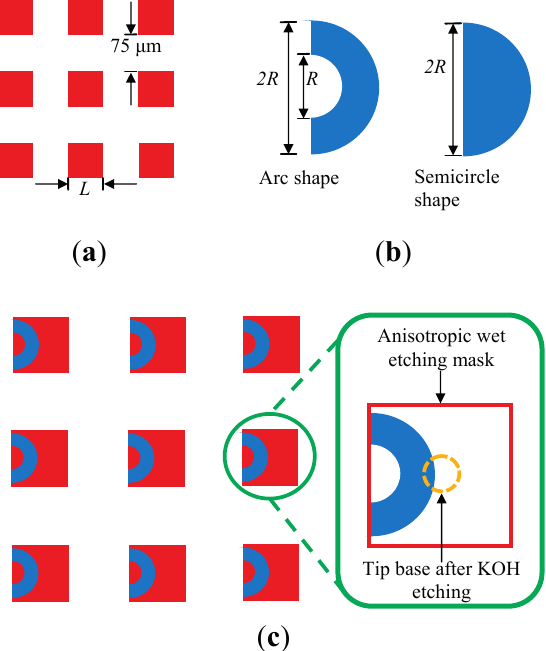
Figure 2. Etching mask design patterns for ( a ) anisotropic wet etching and ( b ) isotropic wet etching; ( c ) The schematic of the combined mask